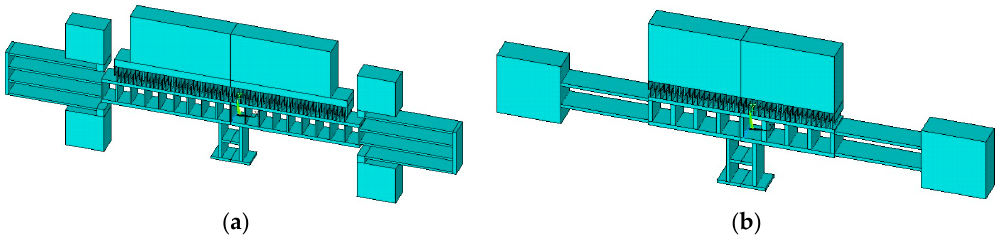
Figure 1. Schematic three-dimensional representation of the comb-drive actuators: ( a ) Design A using folded beam spring and ( b ) Design B using fixed-fixed spring.